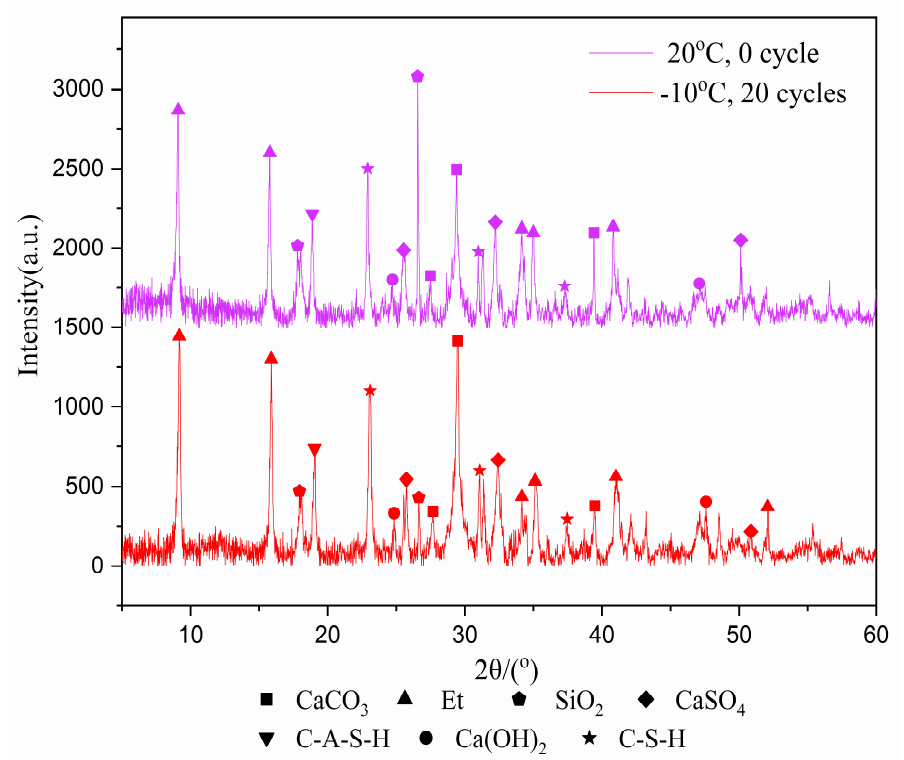
Figure 3. XRD image of 7-day